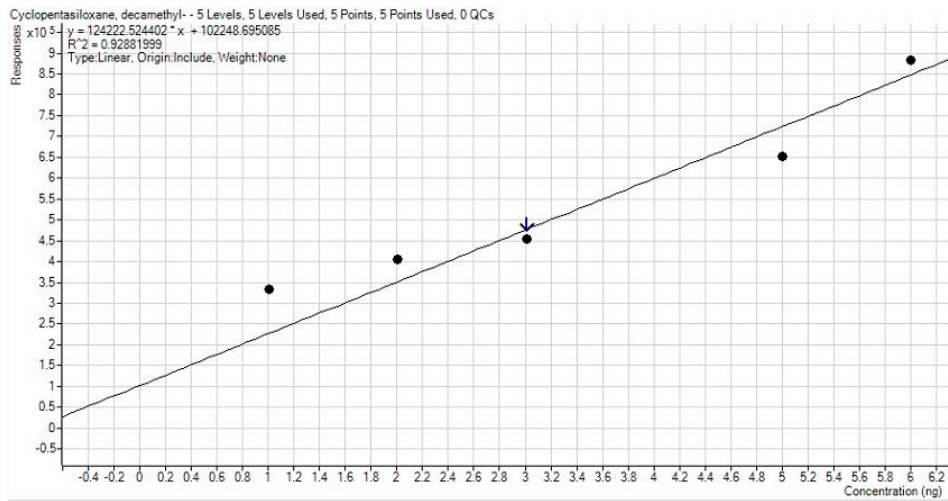
Figure 4. Calibration line for D5.